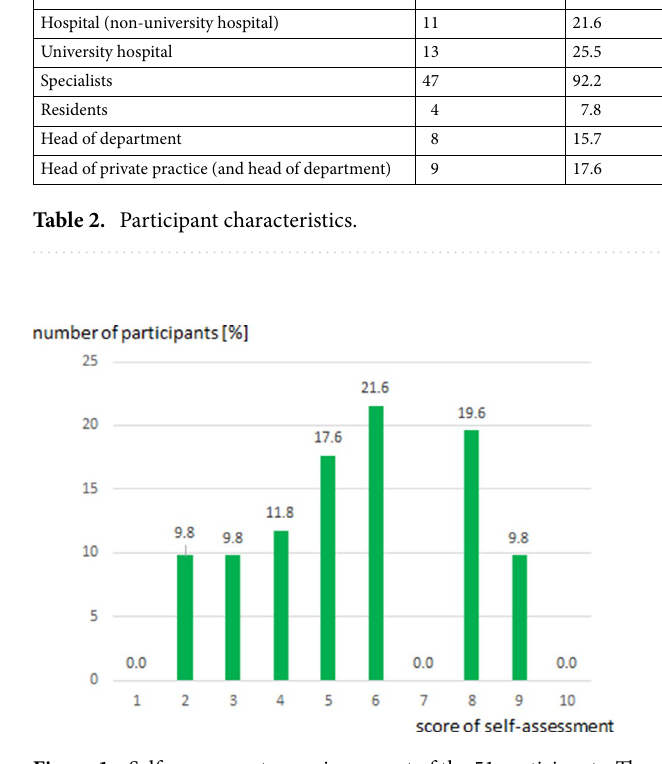
Figure 1. Self-assessment score in percent of the 51 participants. The scale reached from 1 to 10 where 1 refers to “very limited knowledge” and 10 refers to “excellent knowledge” on immune checkpoint inhibitors